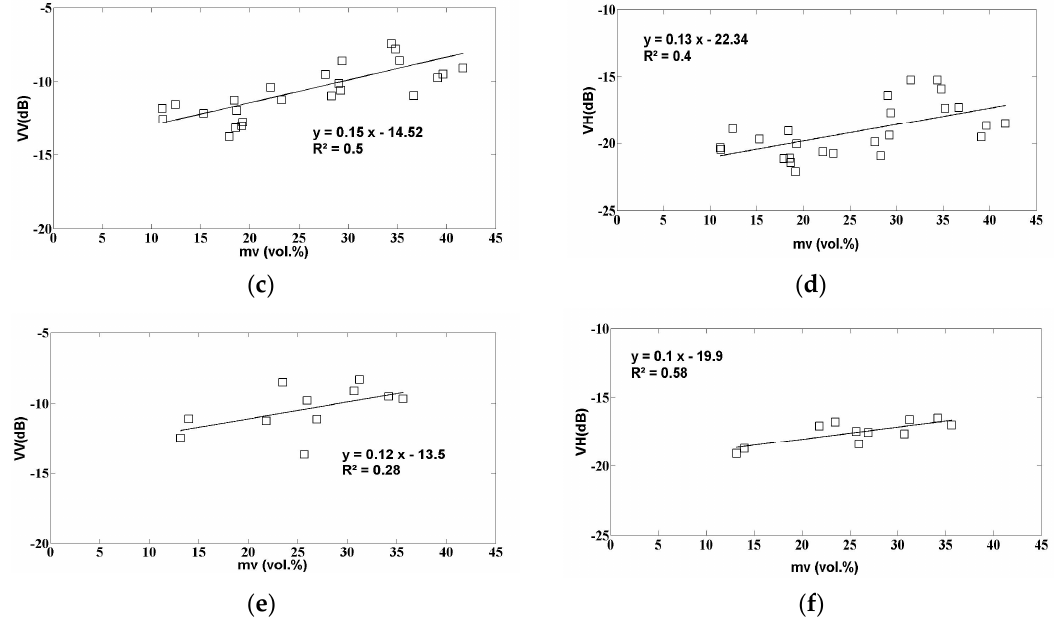
Figure 6. S1 radar data as a function of soil moisture: ( a ) VV polarization, NDVI < 0.25; ( b ) VH polarization; NDVI < 0.25; ( c ) VV polarization, 0.25 < NDVI < 0.5; ( d ) VH polarization, 0.25 < NDVI < 0.5; ( e ) VV polarization, NDVI > 0.5; ( f ) VH polarization, NDVI > 0.5.